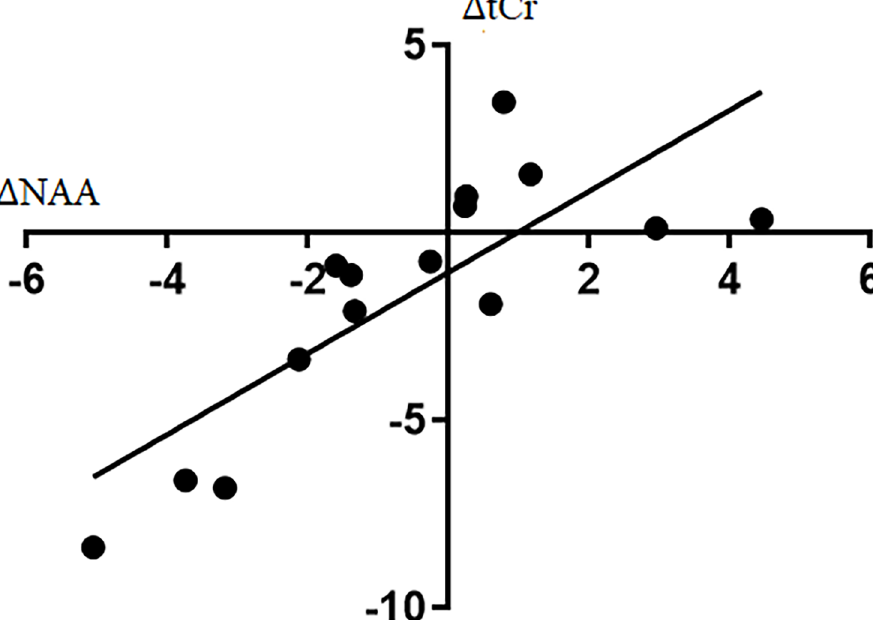
Fig 4. NAA and tCr coupling. The association between the Δ in the absolute concentration of NAA and tCr (stimulation − sham). We observed a strong, positive correlation, indicating NAA and tCr both change in the same direction after stimulation (R 2 = 0.64, p <